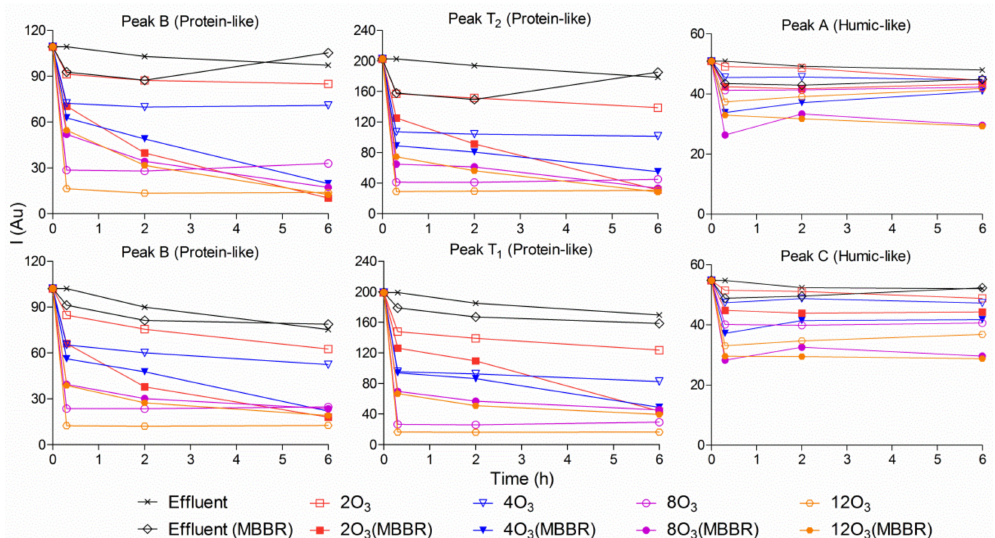
Figure 7. Development of the natural fluorescence of the e ffl uent treated by a single polishing MBBR, four delivered ozone dosages in the laboratory, with or without subsequent MBBR polishing. E ffl uent stands for the pilot hybrid system e ffl uent; E ffl uent (MBBR) stands for e ffl uent treated with only a polishing MBBR; 2O 3 stands for e ffl uent treated with 2 mg O 3 / L; 2O 3 (MBBR) stands for e ffl uent treated with 2 mg O 3 / L followed by a polishing